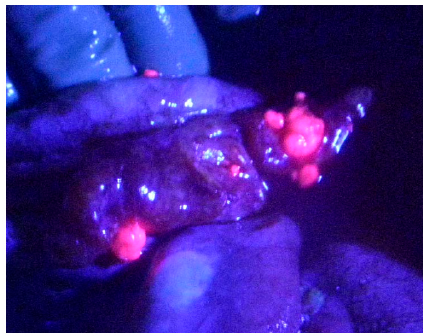
Figure 1. Peritoneal metastasis from ovarian cancer emitted strong red fluorescence under irradiation of violet light after oral administration of 5-aminolevulinic acid. Peritoneal metastases were emitted as red color.